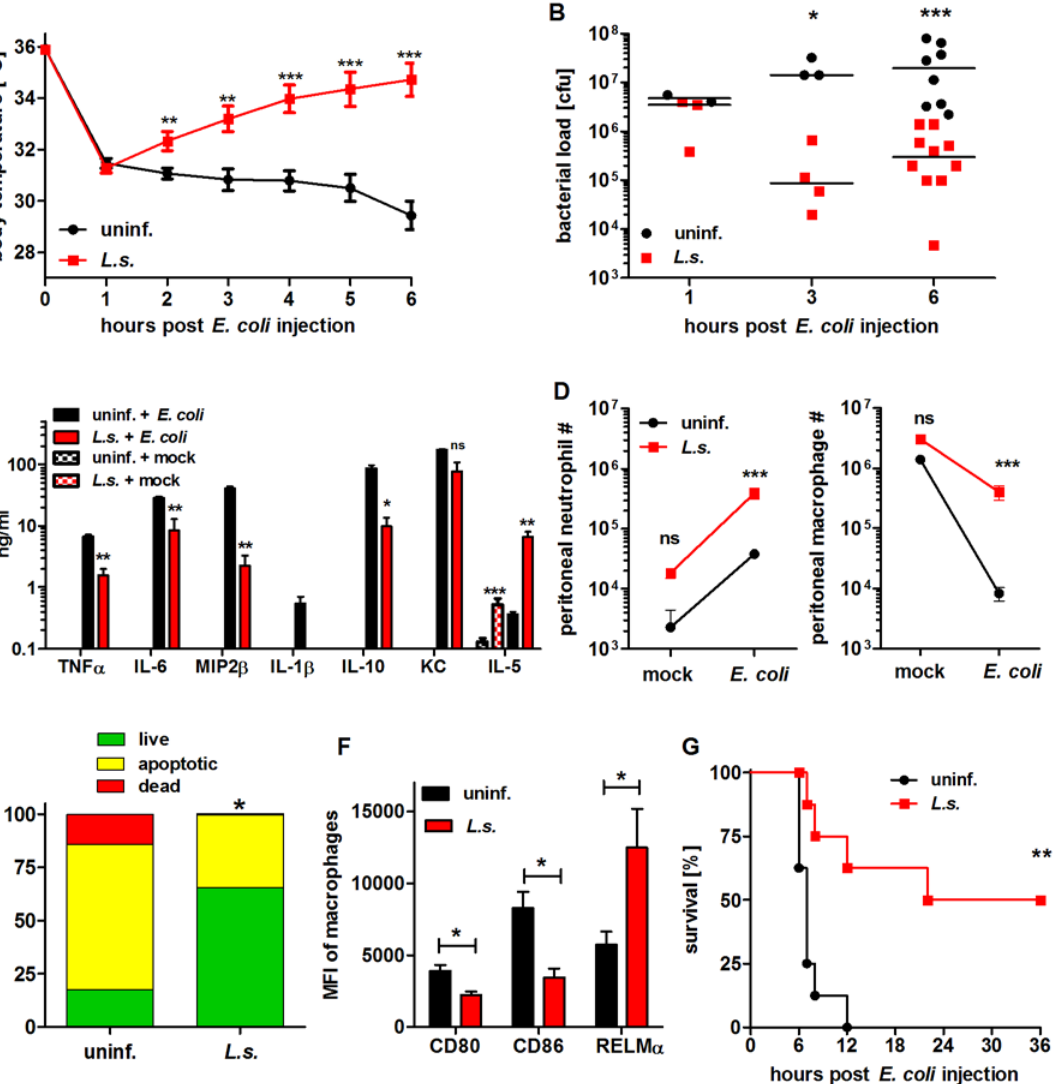
Figure 1. Chronic L. sigmodontis infection improves E. coli -induced sepsis. ( A ) Kinetic of body temperature in response to i.p. E. coli injection of uninfected (n = 17) and chronically L. sigmodontis ( L.s. )-infected mice (n = 19). ( B ) Peritoneal bacterial load and ( C ) serum cytokine/chemokine concentrations (n = 5 – 6/group) of uninfected and L. sigmodontis- infected mice at indicated time points and six hours post E. coli injection or mock injection, respectively. ( D ) Total number of peritoneal Gr1 + neutrophils and F4/80 hi CD11b hi macrophages six hours post injection of E. coli or sterile LB broth (indicated as mock; n = 4 – 6/group). ( E ) Frequencies of propidium iodide-positive, Annexin V-positive and double negative (live) F4/80 + macrophages three hours post E. coli challenge. ( F ) CD80, CD86 and RELM α expression (mean fluorescence intensity) on F4/80 hi macrophages (n = 4/group) six hours post E. coli injection; ( G ) survival of na ï ve and L. sigmodontis -infected mice after i.p. injection with E. coli (n = 8/group). ( A ) Shows pooled data from two independent experiments and ( B-D, F ) show one representative dataset of three independent experiments. Data in ( A ) is displayed as mean +/- SEM and was tested for statistical significance by 2-way ANOVA and Bonferroni post hoc test; data in ( B-F ) was tested for statistical significance by Mann-Whitney-U-test. Indicated statistical significant differences in ( C ) are based on comparisons of E. coli -treated groups and, in the case of IL-5, non- E. coli -treated groups ( * p < 0.05, ** p < 0.01, *** p < 0.001); ( G ) was tested for statistical significance by Mantel-Cox Log-rank test (p =